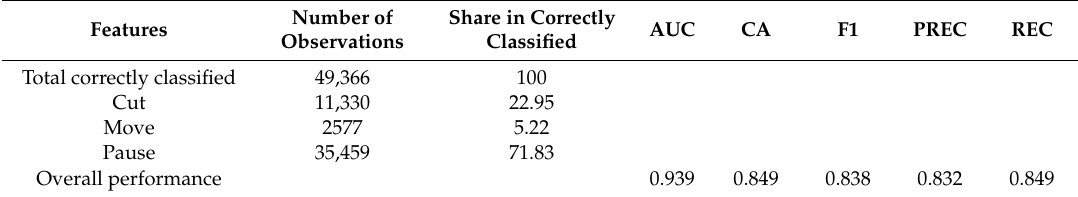
Table 4. Number and share of correct classifications in the testing dataset.